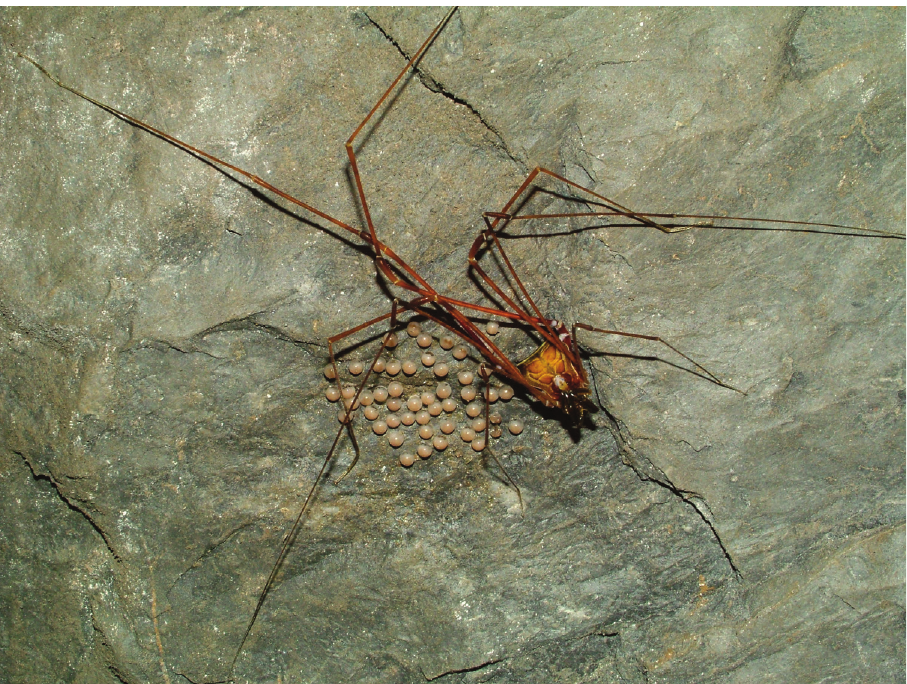
Figure 3. Acutisoma spelaeum (Arachnida: Opilioes), an obligatory trogloxene from caves in southeastern Brazil: female taking care of eggs (Photo: Renata